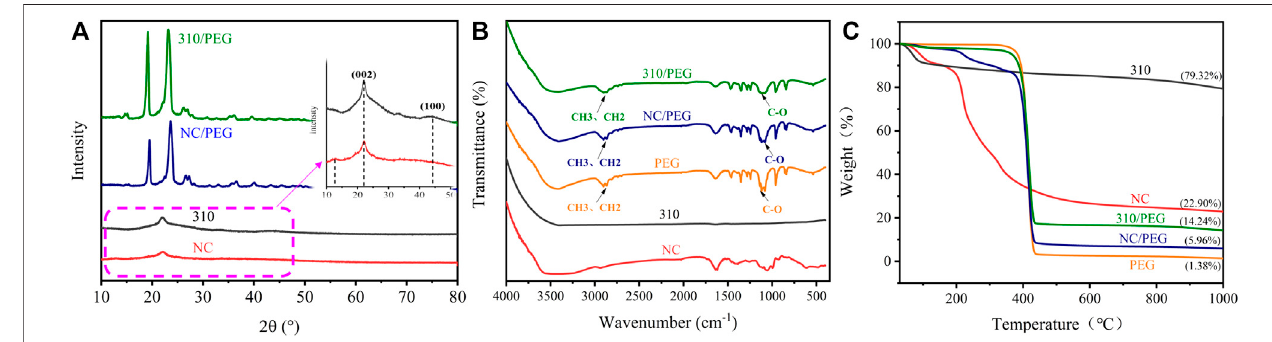
FIGURE 4 | Characterization of samples performed by (A) XRD, (B) FT-IR, and (C)